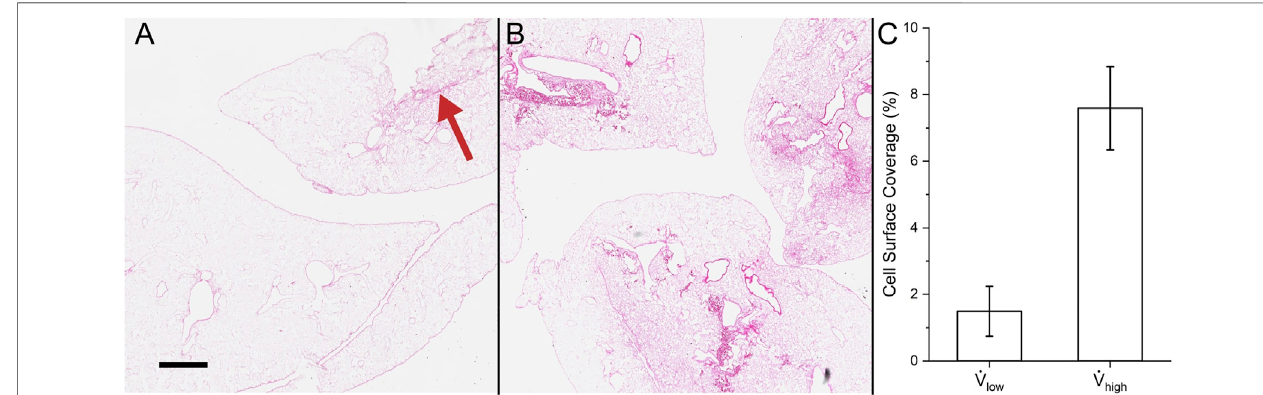
FIGURE11| Cellsurfacecoverageinexperiments.Hematoxylinandeosinstainof (A) reseedingwithlow fl owrate(redarrowindicatesthesmallgroupofcells)and (B) high fl ow rate. (C) Quanti fi cation of the lung surface area that is seeded. Scale bar is 500 µ m.